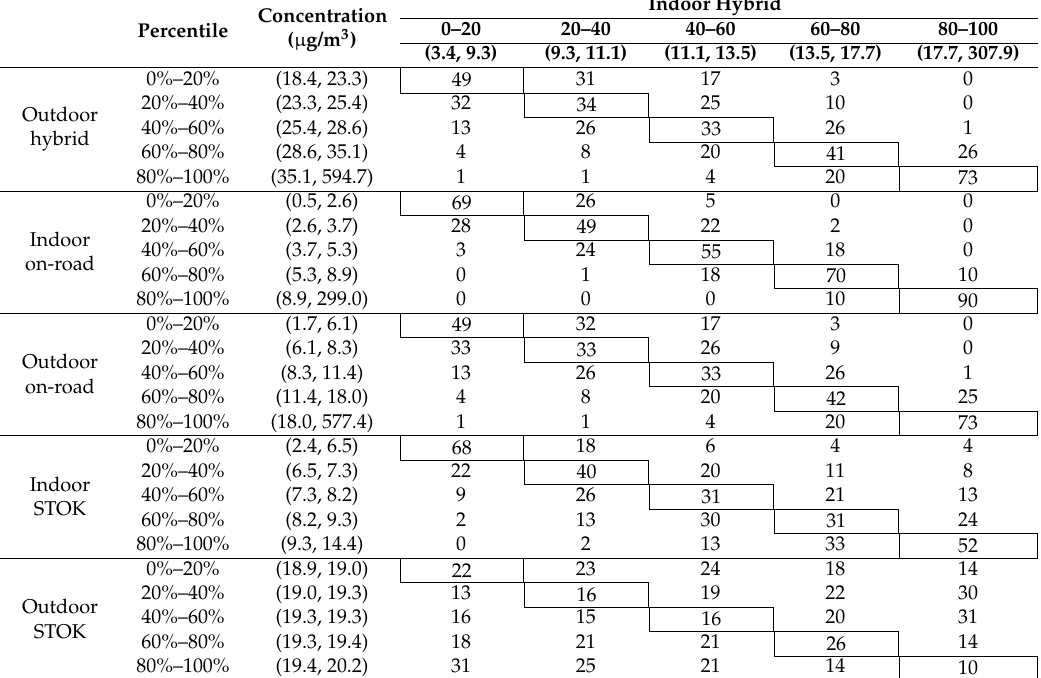
Table 4. Contingency table for NO x showing agreement between exposure quintiles. The values represent percentage of Census blocks in each quintile. Concentration ranges are shown in parentheses. Boxed percentages along diagonals would be 100% for a perfect match.